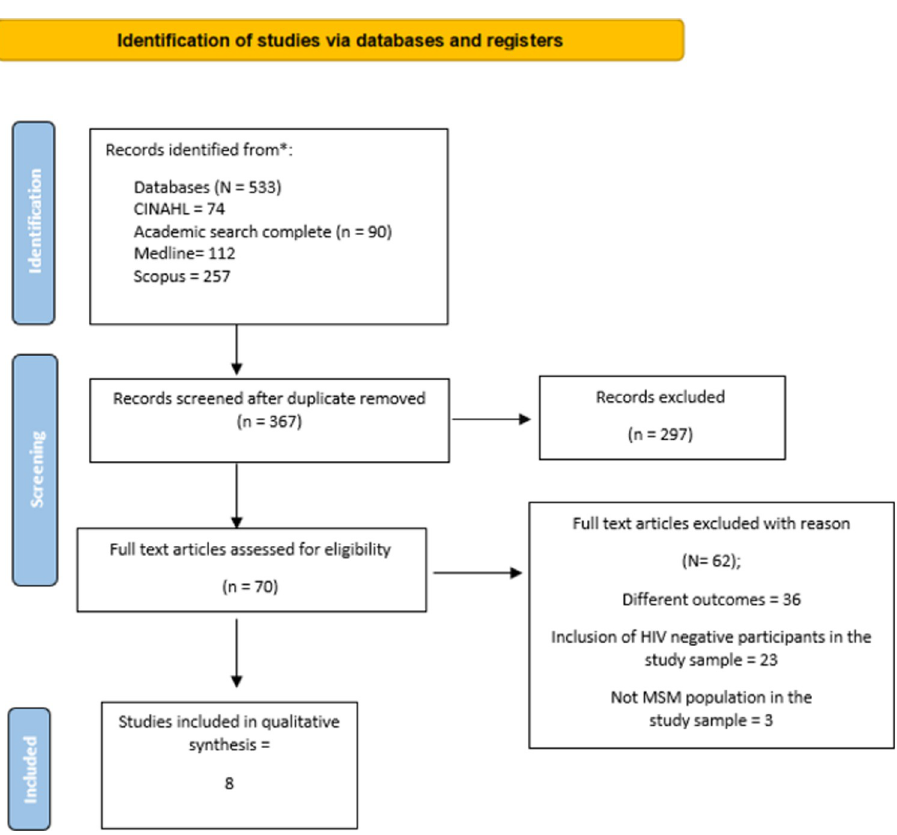
Fig 1. Preferred Reporting Items for Systematic Reviews and Meta-Analyses (PRISMA) flowchart for selecting studies.